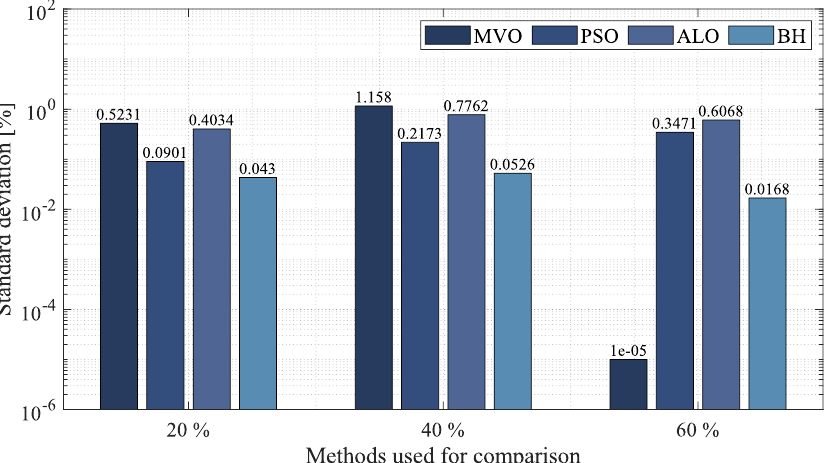
Figure 11. Percentage of standard deviation obtained by the MVO in the 33-node radial test system compared to other